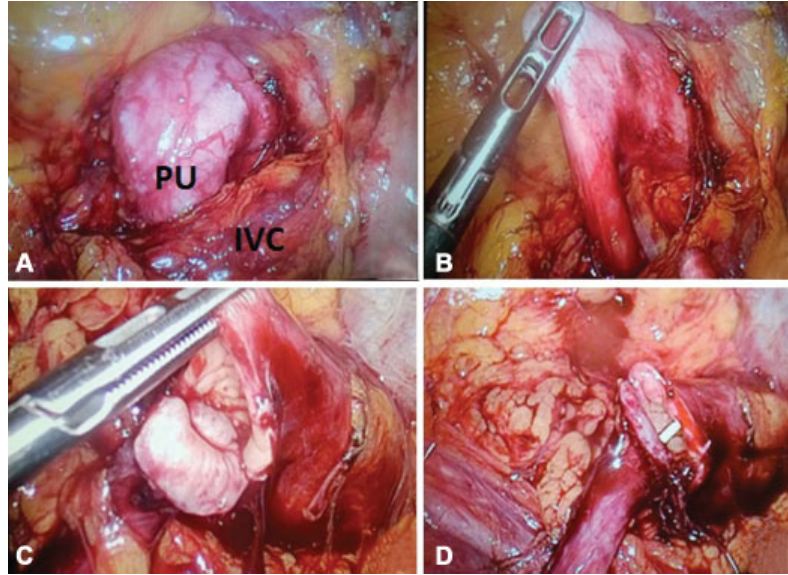
Fig. 2 Intraoperative images of the proximal dilated right ureter (case 2). ( A ) Dilated proximal ureter (PU) crossing the inferior vena cava (IVC). ( B ) Mobilization of the PU with narrowed segment under the IVC. ( C ) Stenotic tract of the ureter excised. ( D ) Uretero-ureteric anastomosis after